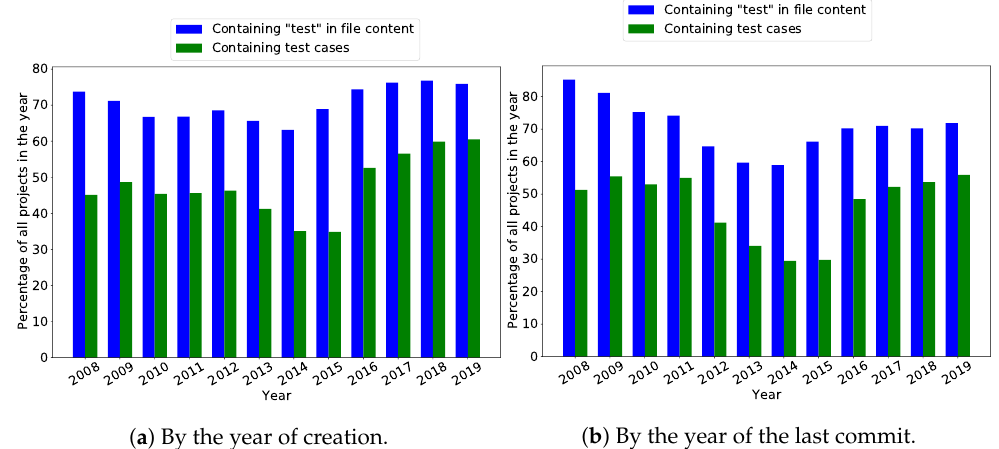
Figure 7. Year percentage comparison of projects with non-zero “test” occurrences and test